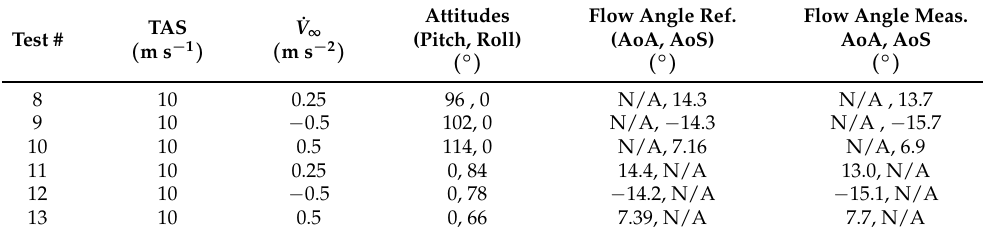
Table 3. Numerical ASSE estimation exciting the accelerometer with steady state